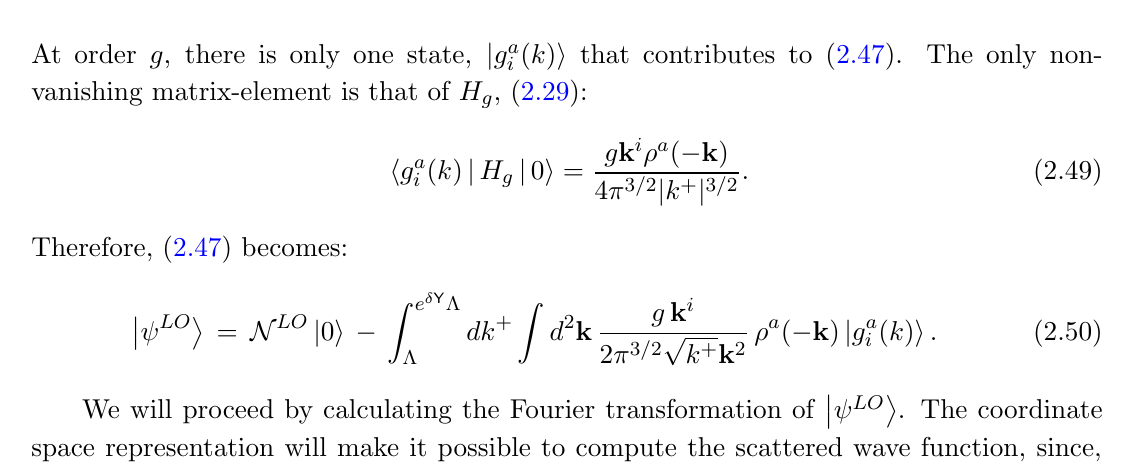
At order g , there is only one state, j g a vanishing matrix-element is that of H